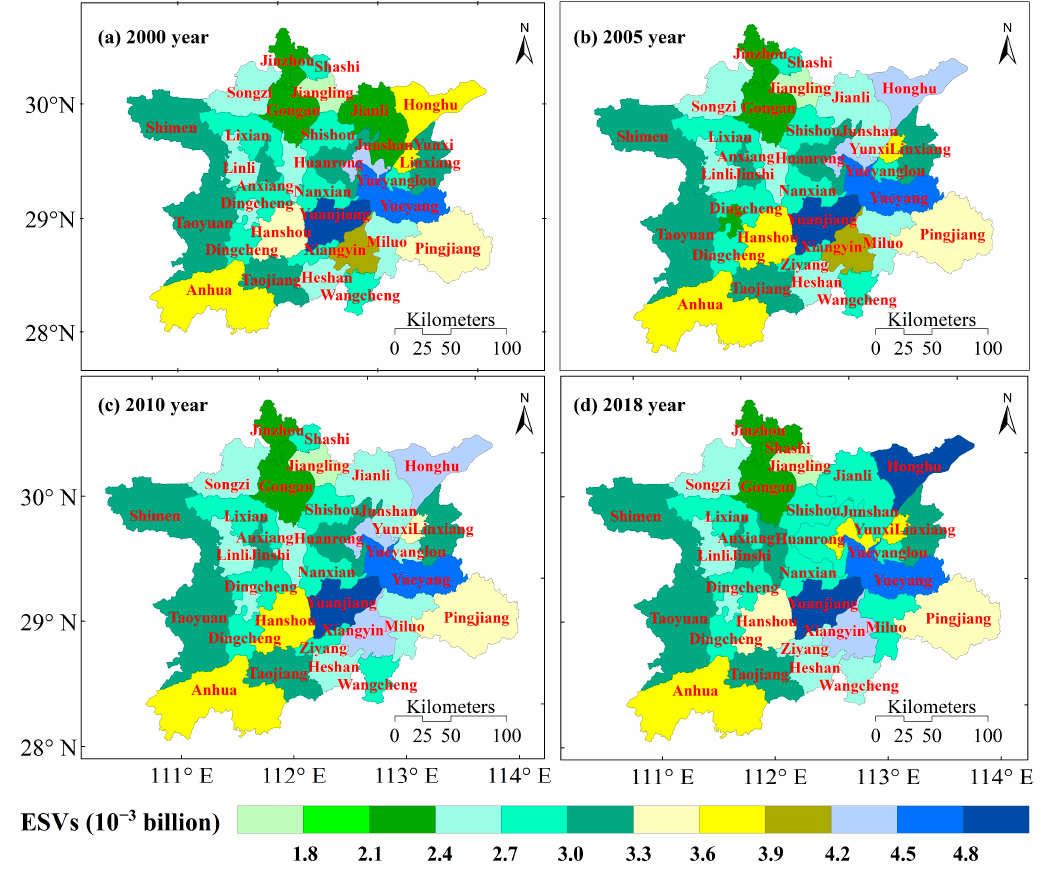
Figure 4. Spatial distribution of ESVs per county (city, district) in the Dongting Lake.